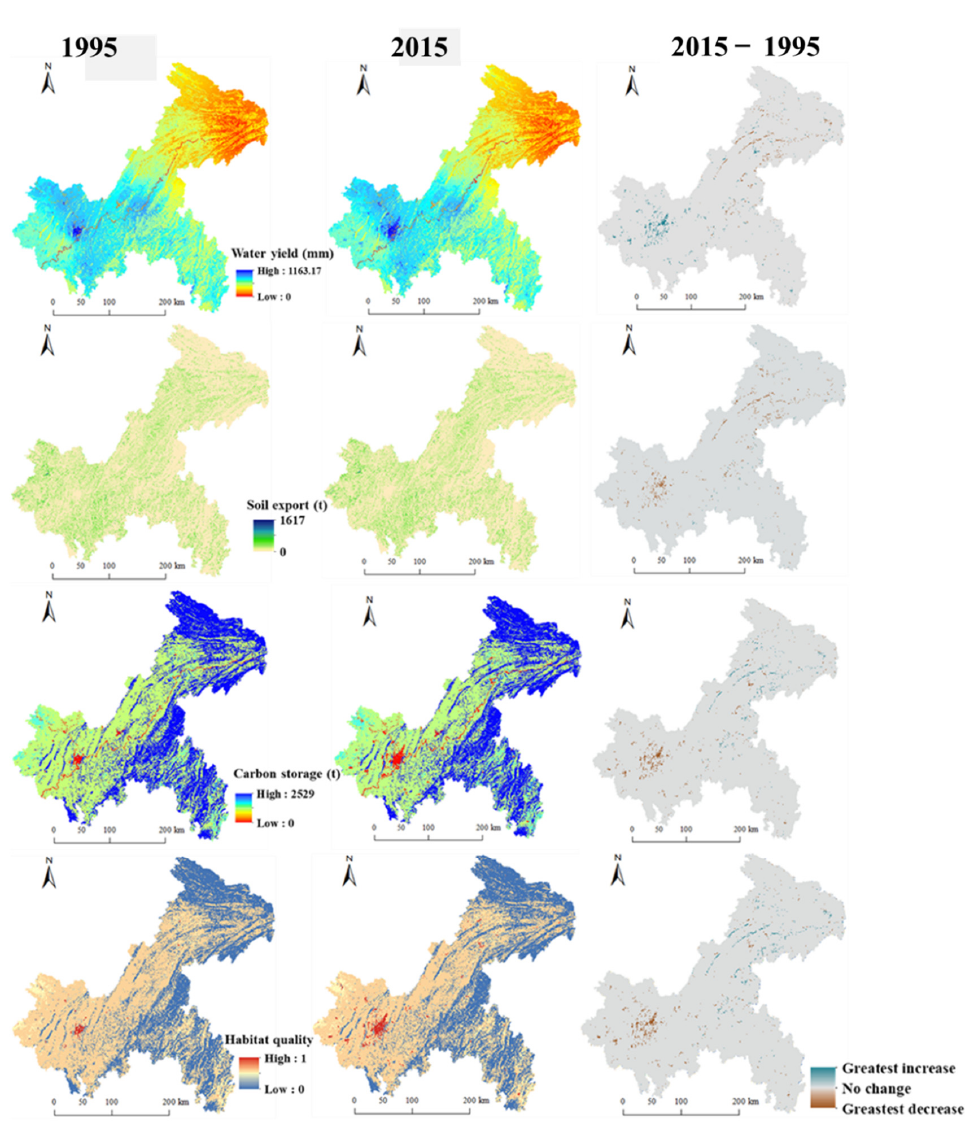
Figure 5. Spatial distributions of WY, SE, CS, and HQ in 1995 and 2015. The right ‐ most column represents the changing areas of the four ESs.